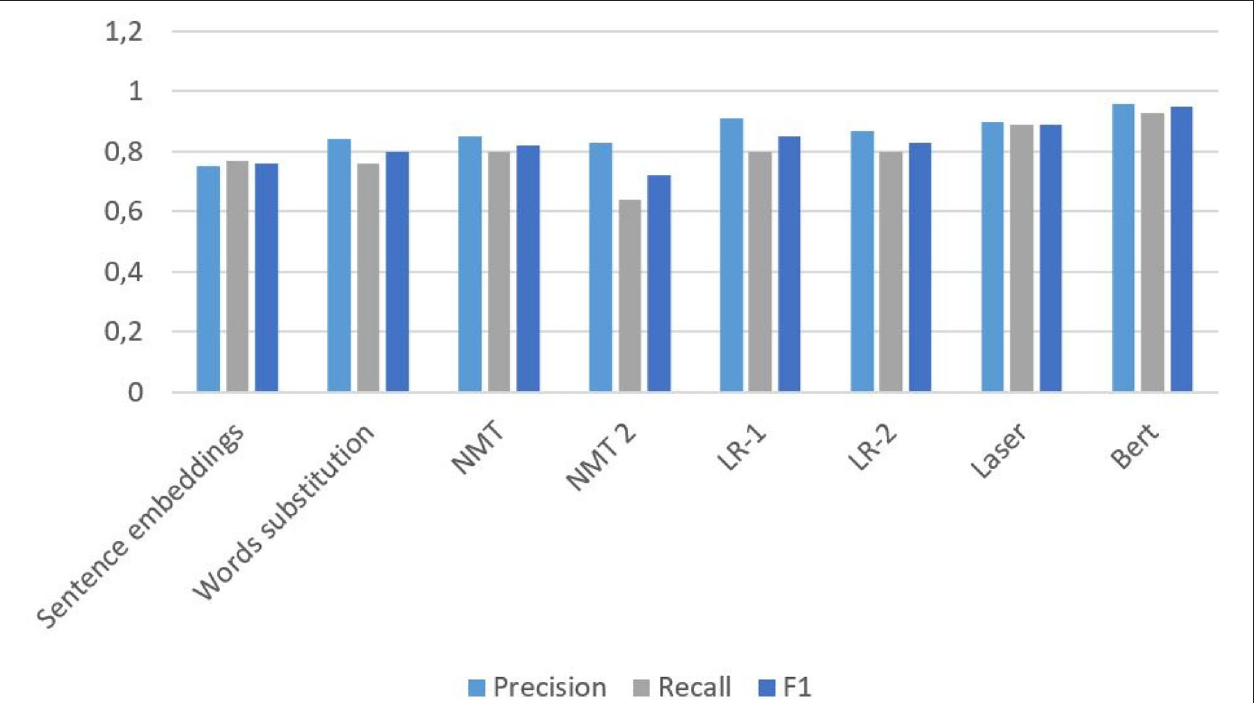
FIGURE 2 | Results of methods from article (Zubarev and Sochenkov, 2019) with Negative-1.